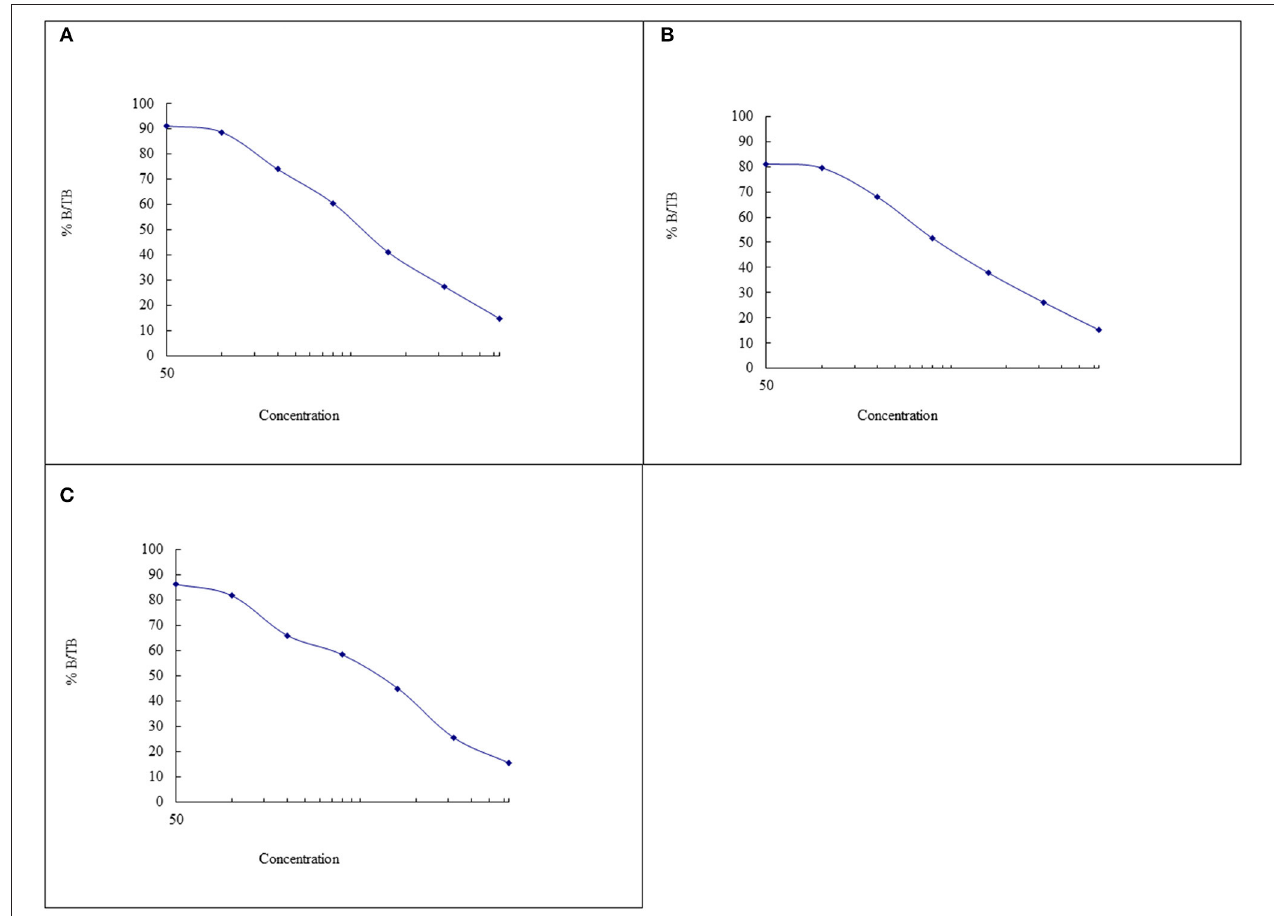
FIGURE 2 | The cortisol standard curves from the assays conducted on (A) the 27th of May 2021, (B) 24th of June 2021, and (C) 27th of July